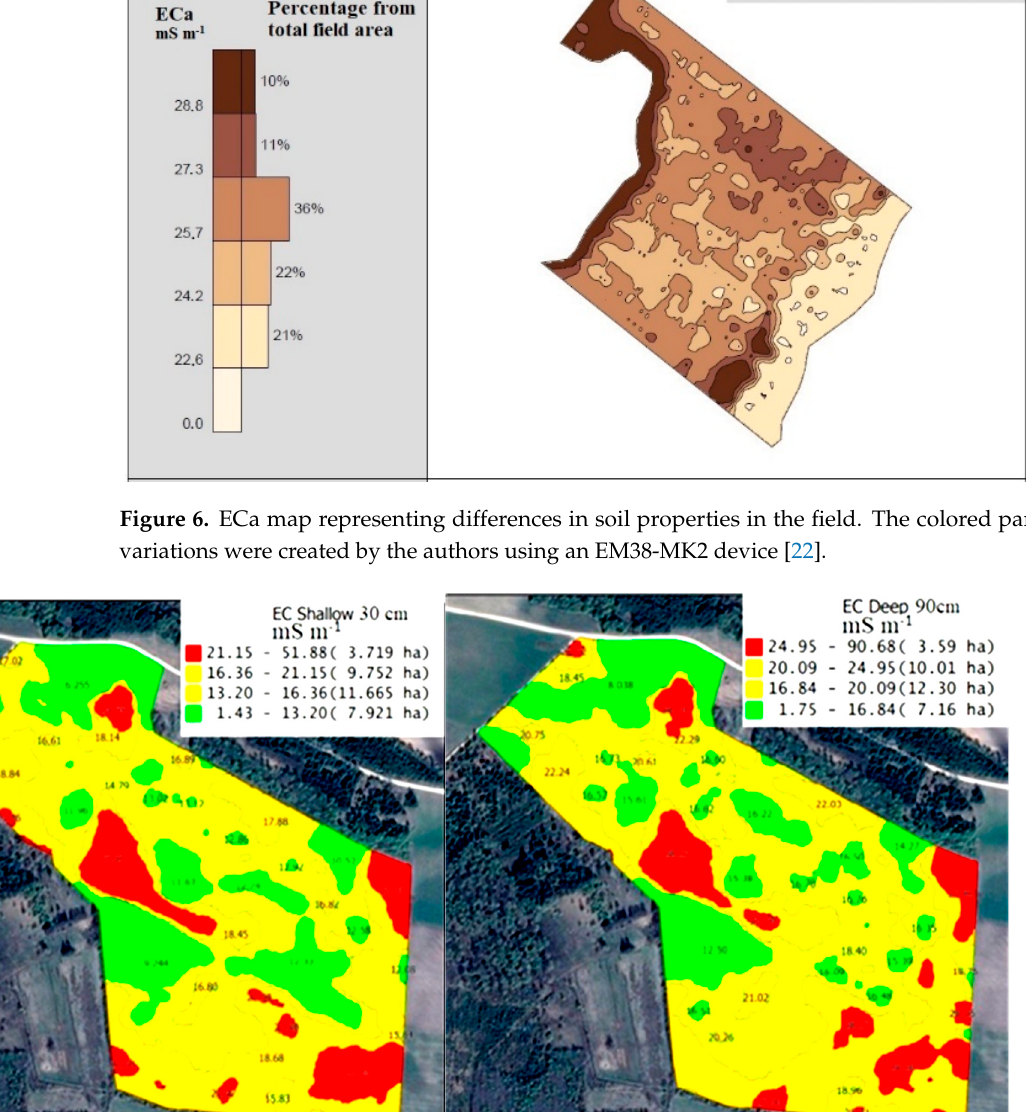
Figure 6. ECa map representing differences in soil properties in the field. The colored parameter variations were created by the authors using an EM38-MK2 device [22].